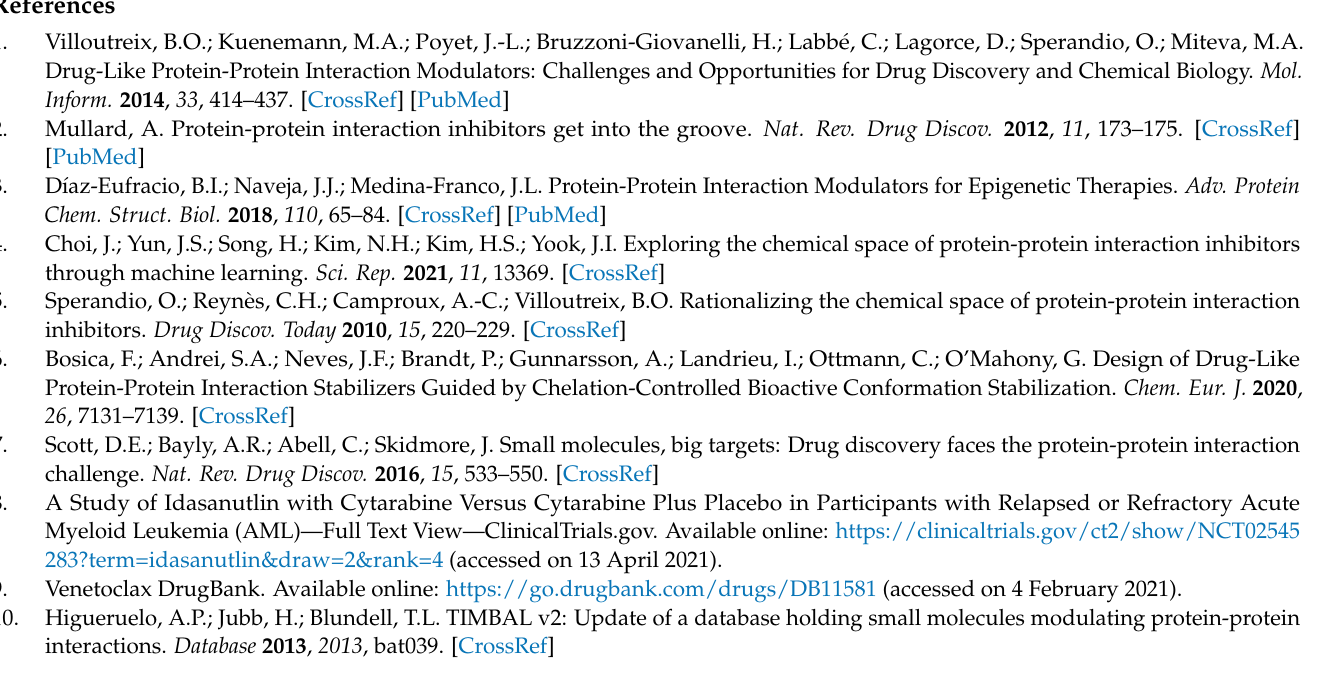
Table S2: RF setup information; Table S3: LRG setup information; Table S4: SVM setup information; Table S5: RF metrics values; Table S6: LRF metrics values; Table S7: SVM metrics values; Table S8: Statistical values of RF models; Table S9: Statistical values of LRG models; Table S10: Statistical values of SVM models; Table S11: RF models validation results; Table S12: LRG models validation results; Table S13: SVM models validation results; Figure S1: RF metrics heatmap; Figure S2: LRG metrics heatmap; Figure S3: SVM metrics